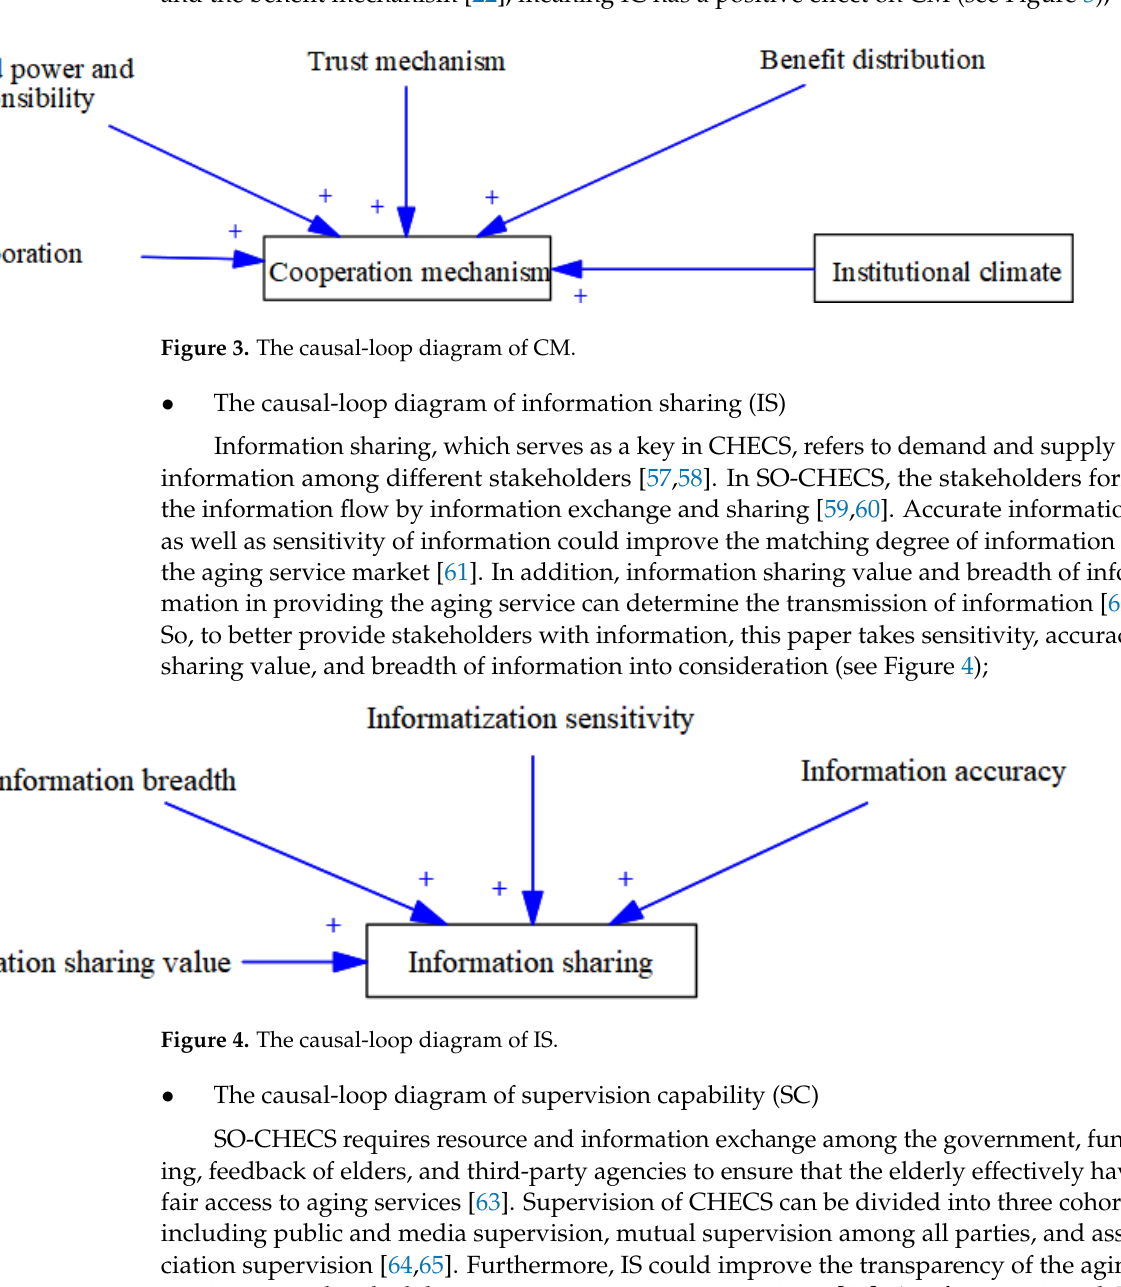
Figure 3. The causal-loop diagram of CM.